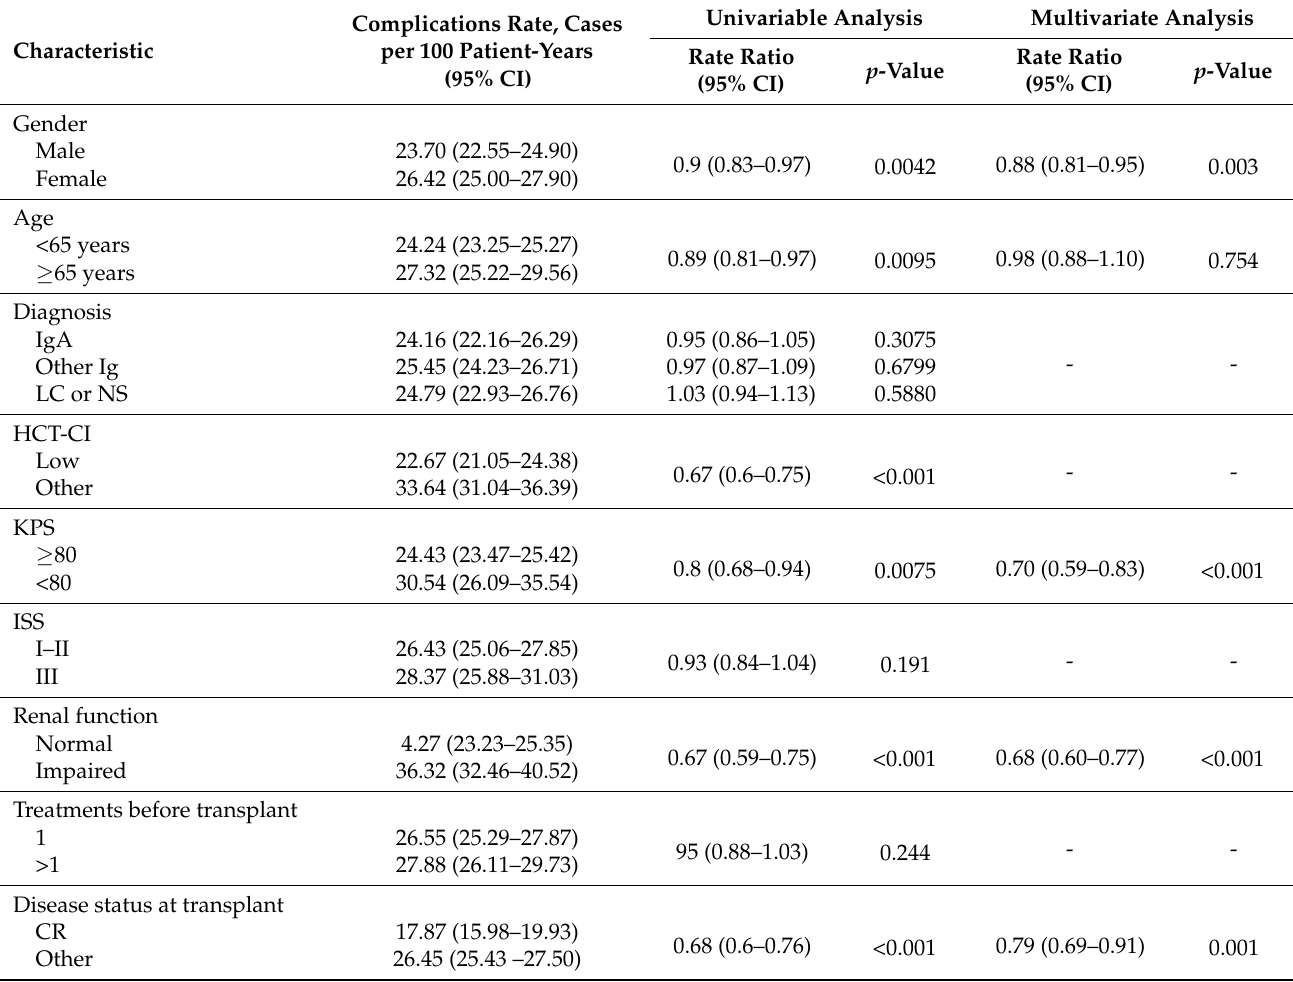
Table 3. Univariable and multivariable analysis of occurrence of complications occurring within first 100 days after the first